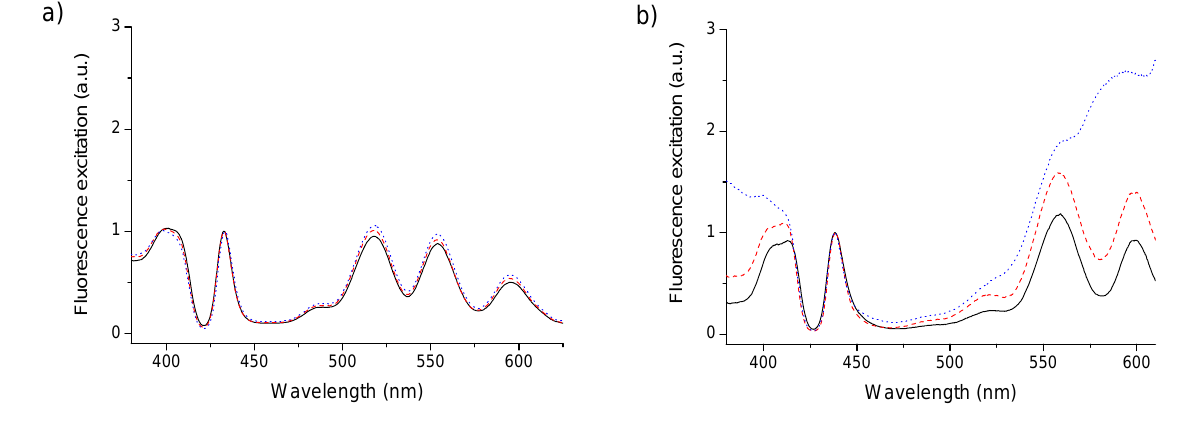
Figure 2. Flourescence excitation spectra of the G0 (solid), G2 (dash) and G4 (dotted) variants of dendrimer capped TPP. (a) Acetonide-G (b) Acetonide-G -prop-TPPZn for emission at 660 nm. x